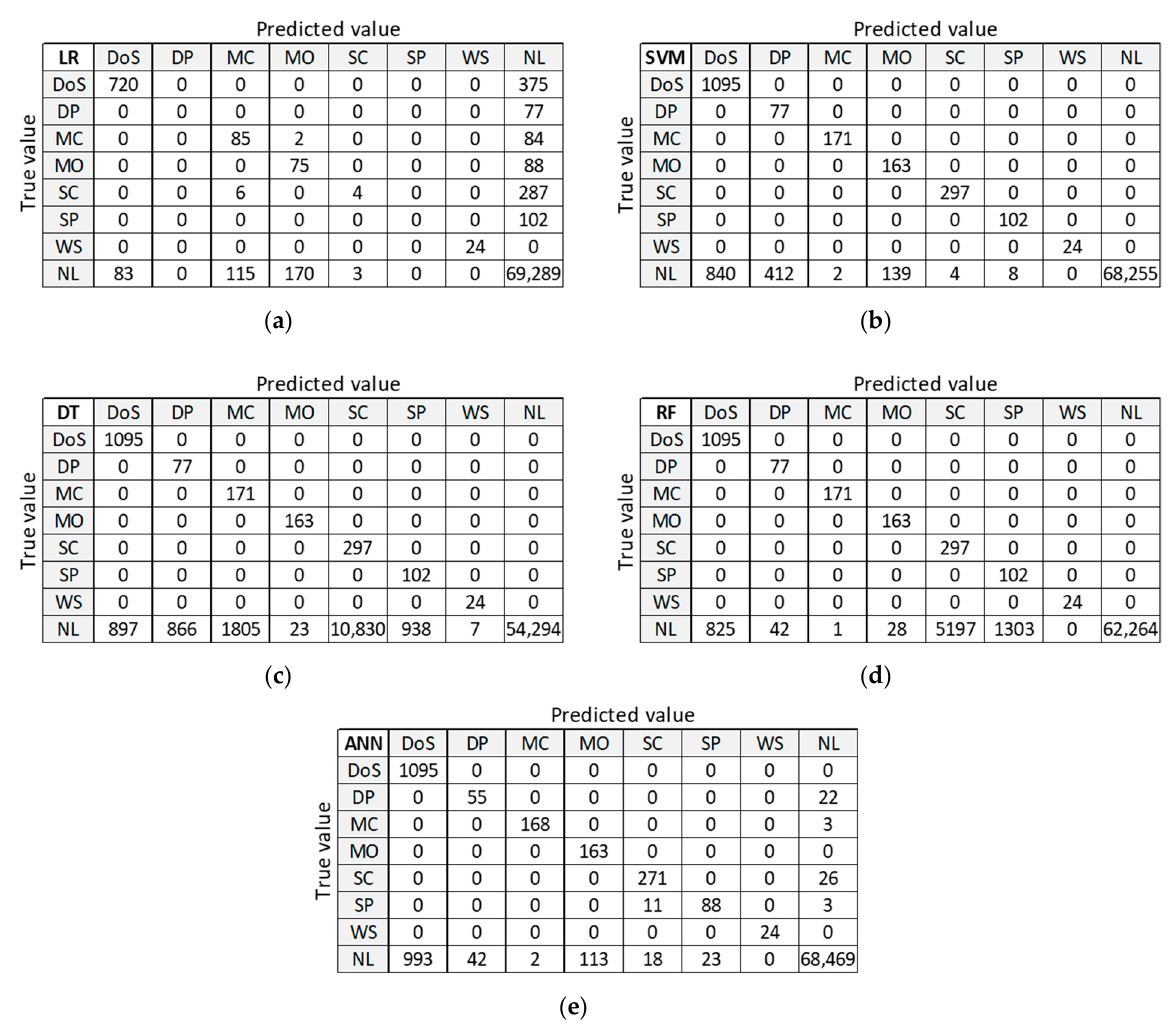
Figure 14. Confusion matrix on test dataset for training dataset DC5: ( a ) LR; ( b ) SVM; ( c ) DT; ( d ) RF; ( e ) ANN.